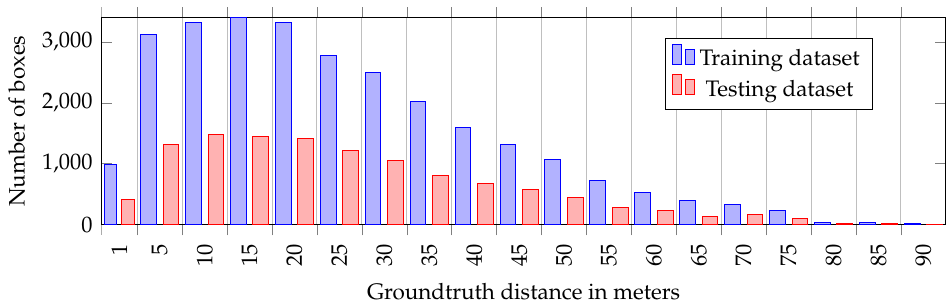
Figure 2. The distribution of object distances in training and testing datasets. The graph is clipped to the maximum distance of 90 m to increase